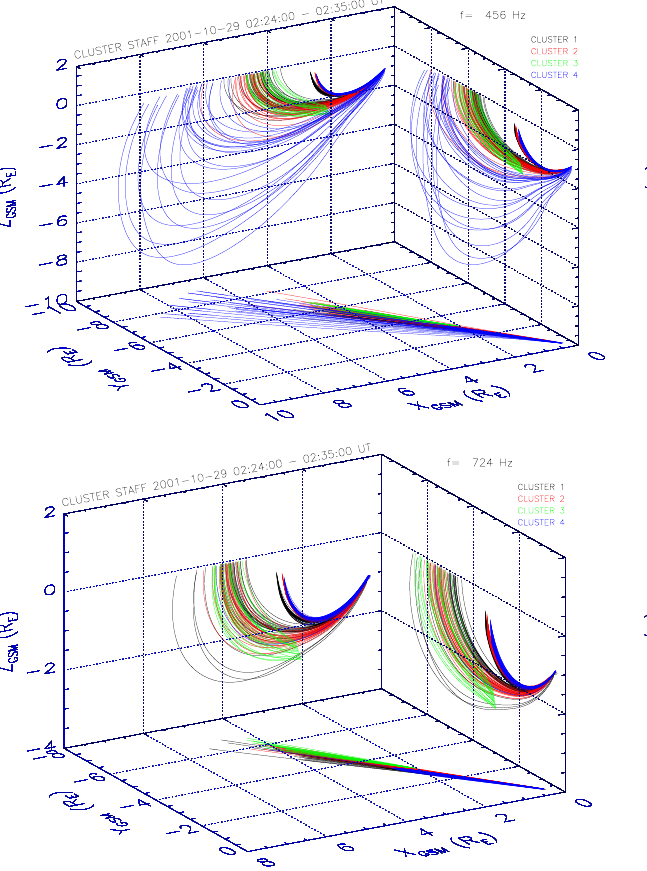
Fig. 7. The ray plots are represented (together with their projec- tions in the three planes) in the top and bottom panels for the time intervals 02:56–03:05UT and 03:10–03:16UT, respectively. The top and the bottom panels correspond to 912Hz and 2896Hz, re-